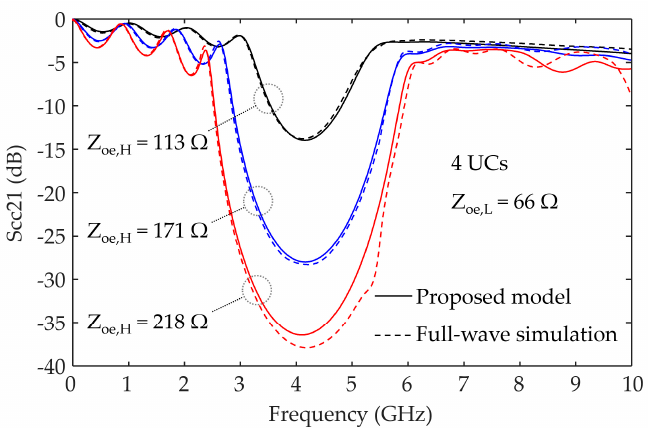
Figure 7. Effect of even-mode characteristic impedance ( Z oe ) on CM noise suppression for model verification.